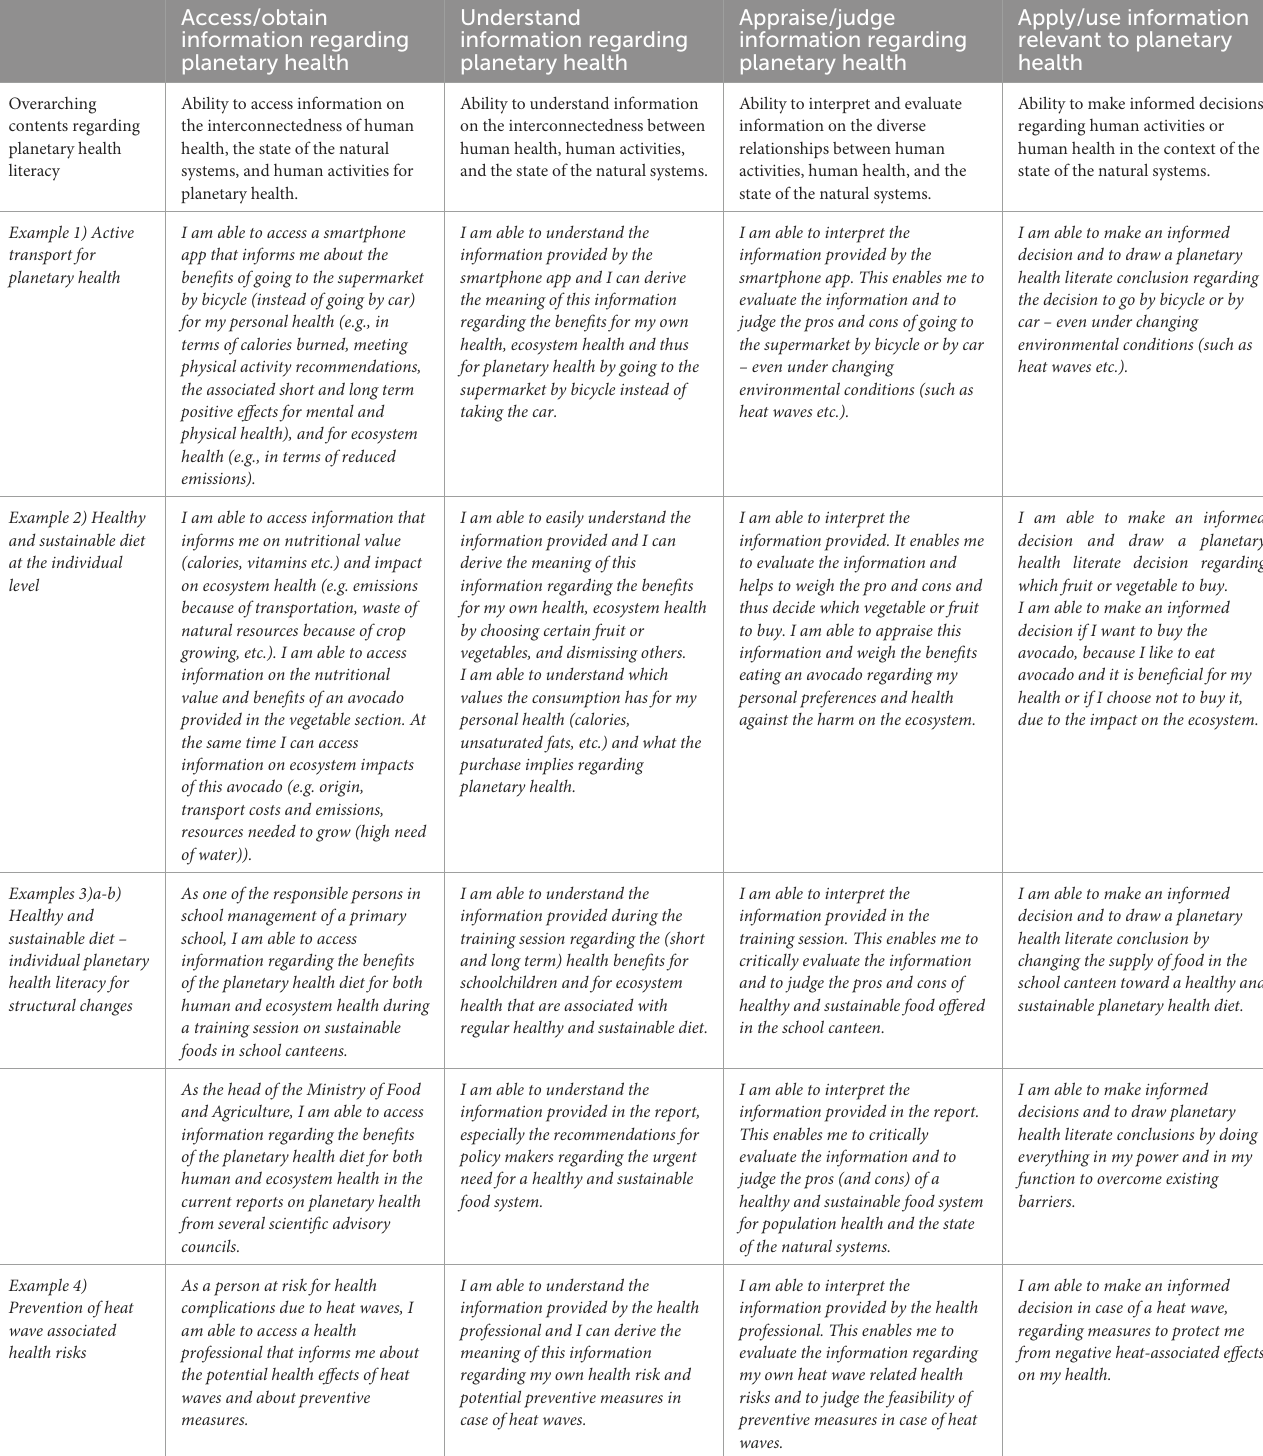
TABLE 3 Examples of thematic areas and of their application regarding the four core competencies of planetary health